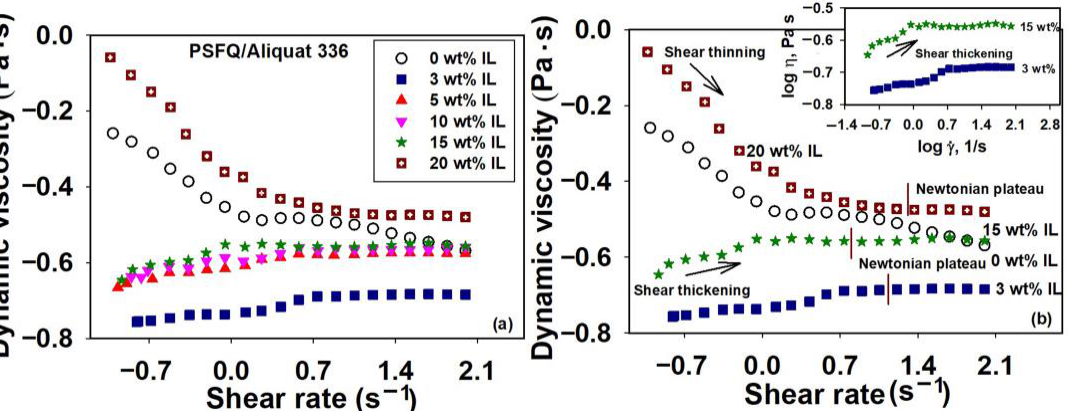
Figure 2. Rheological profile illustrated by double—logarithmic plots of dynamic viscosity ( η ) versus shear rate ( γ̇ ) for PSFQ/Aliquat 336 system at 25 °C and various mixing ratios, namely ( a ) Aliquat 336 compositions varying between 3 wt% and 20 wt% and ( b ) Aliquat 336 compositions of 3 wt%, 15 wt% and 20 wt%, for illustration of the viscosity changes in the two regions. Small image is inserted for better visualization.